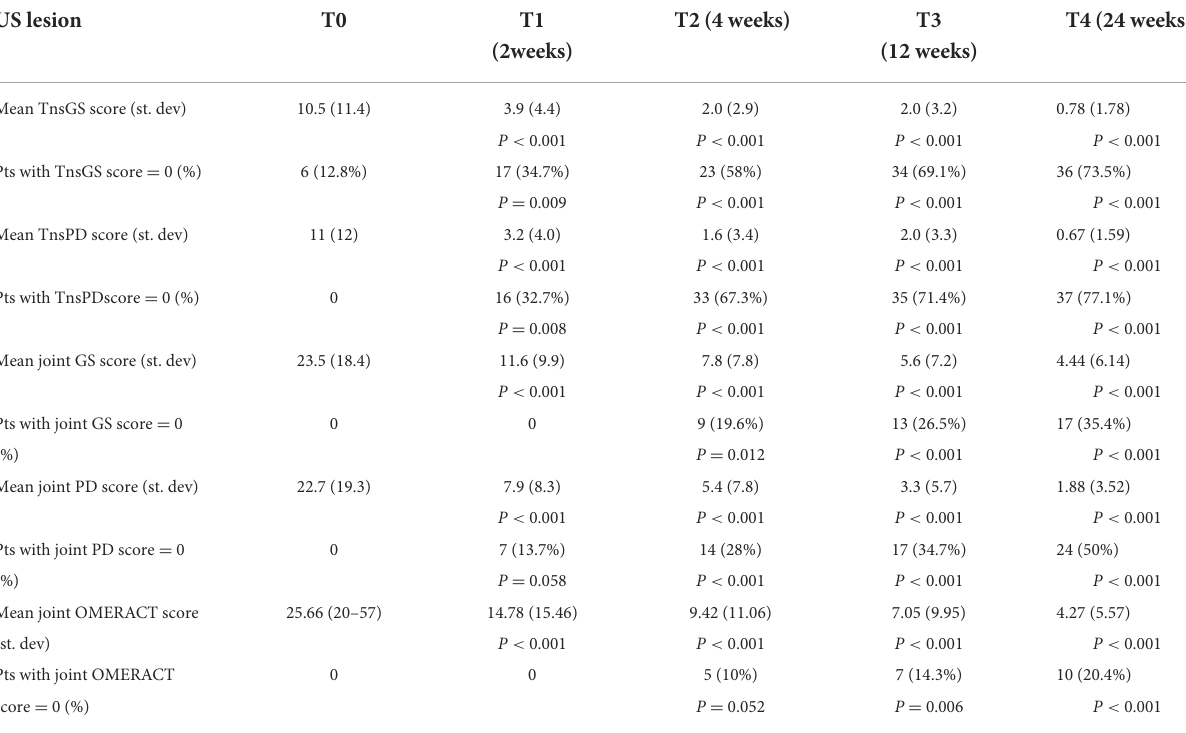
TABLE 3 Variations of ultrasound lesion scores during treatment.